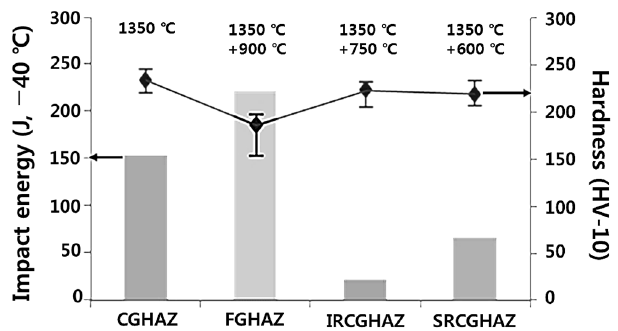
Figure 8. Charpy-absorbed energy and hardness distribution for each simulated HAZ.